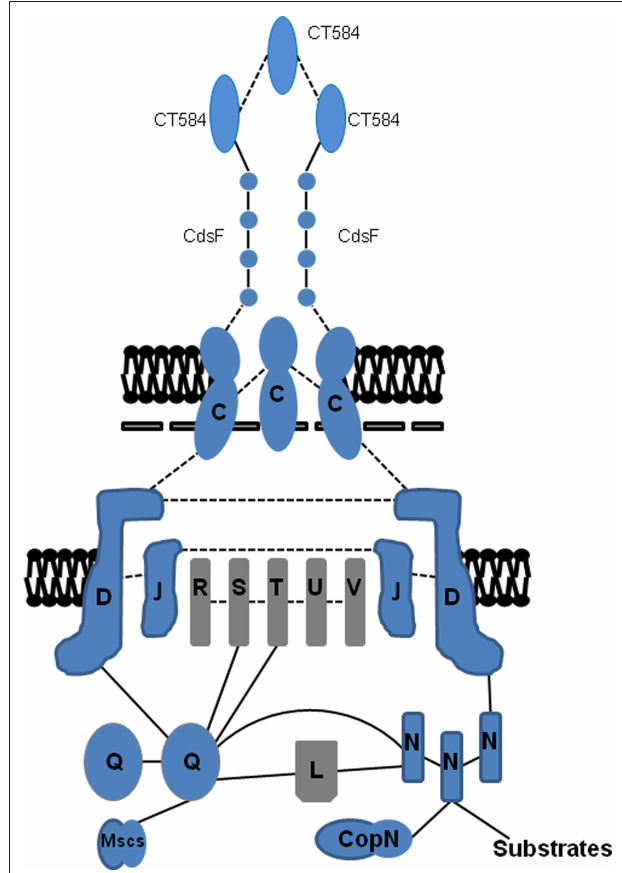
Figure 3 | Summary model of protein–protein interactions among chlamydial T3SS components. Respective proteins are placed based on homology to components in other T3SSs (gray) or based on published in vitro or in vivo data in Chlamydia (blue). Interactions are depicted as dashed lines for predicted interactions or solid lines for those that have been established experimentally. Flagellar homologs are omitted for